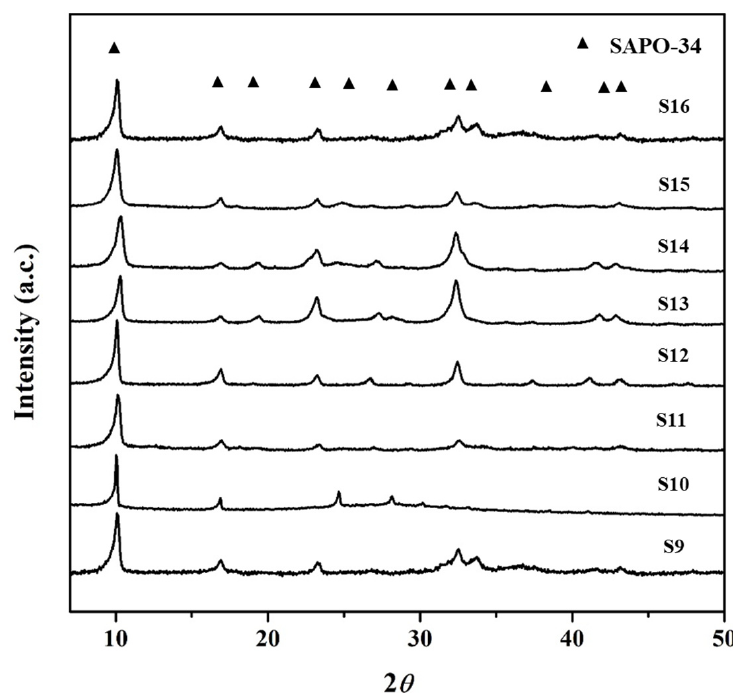
Figure 4. XRD for the as-synthesized SAPO-34 particles (S9–S16) with varied P 2 O 5 concentration ( y ), synthesis time, and variation in phosphoric acid addition time.